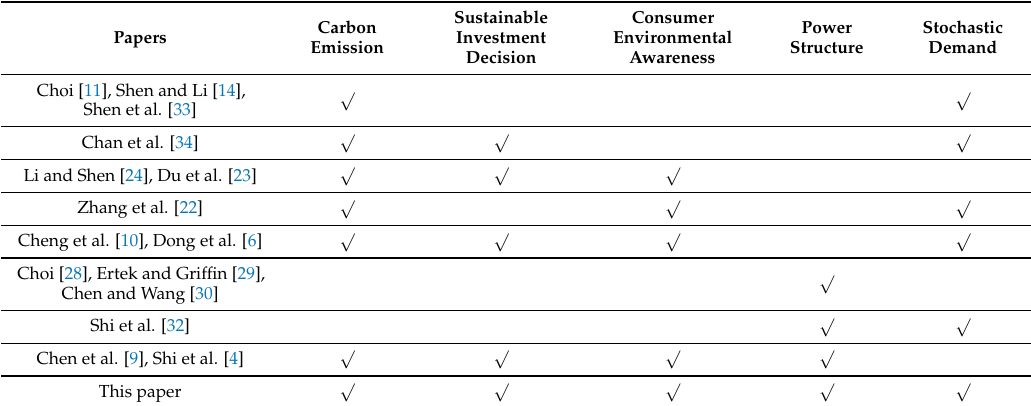
Table 1. Positioning of this paper in the